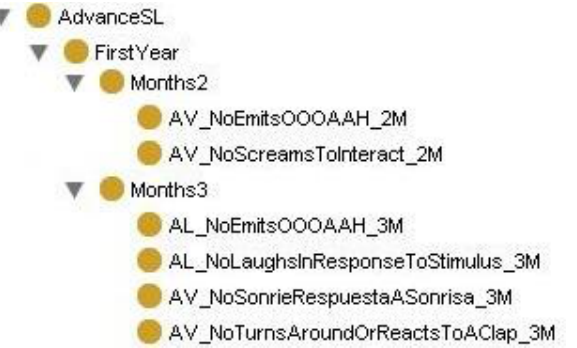
Figure 4. Ontology of the system in Protégé. This figure shows Ontology of system in Protégé for the classes of months 2 and